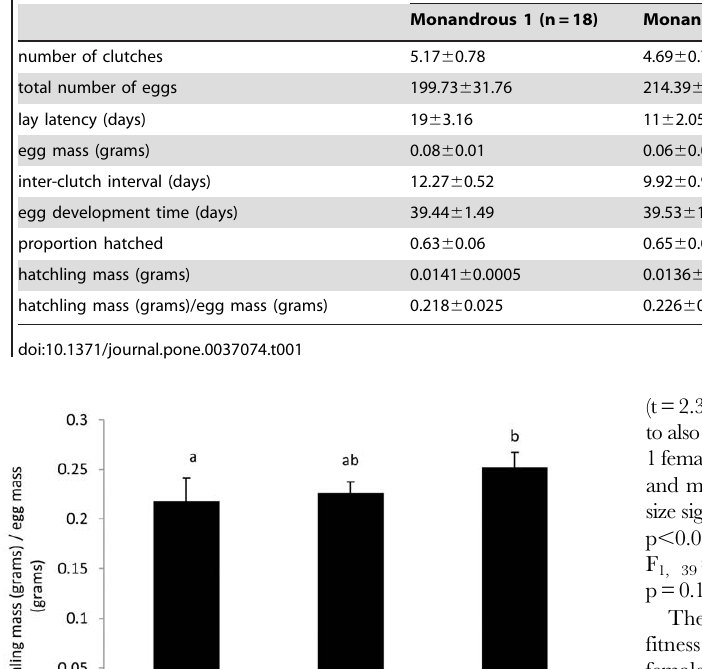
Variable Mating treatment (means and standards errors)